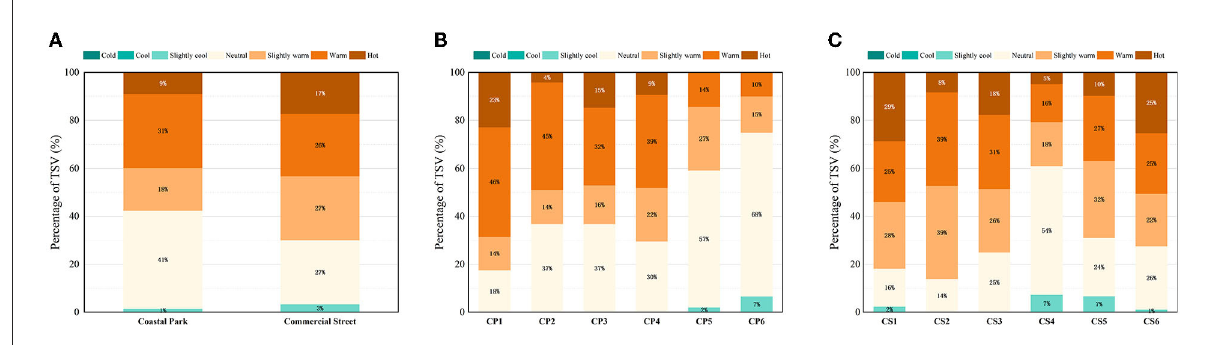
FIGURE4 TSV in open spaces during summer: (A) Both study areas, (B) coastal park, and (C) commercial